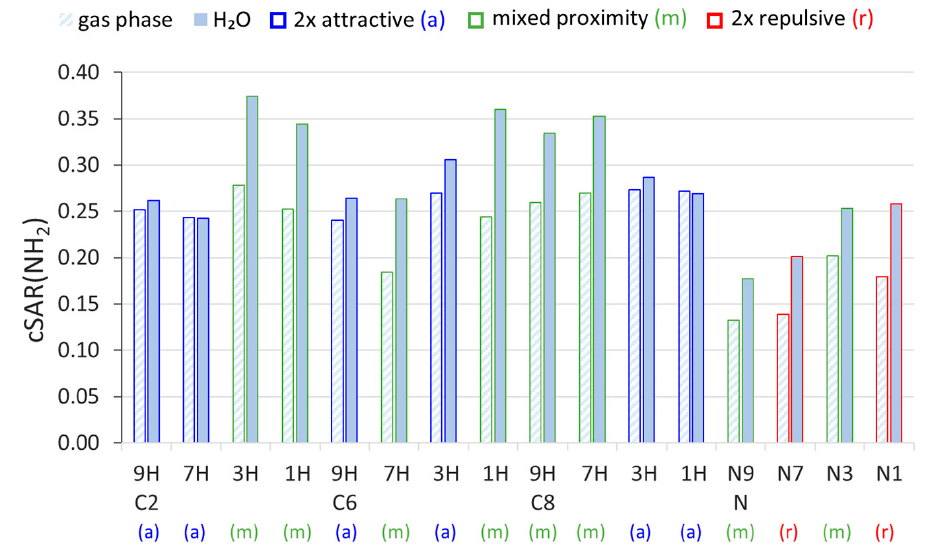
Figure 1. Values of cSAR(NH 2 ) in 9H, 7H, 3H, and 1H tautomeric forms of C- and N-NH 2 derivatives of purine, calculated in the gaseous and aqueous phases. The color coding of each bar indicates the proximity interactions present in each system.